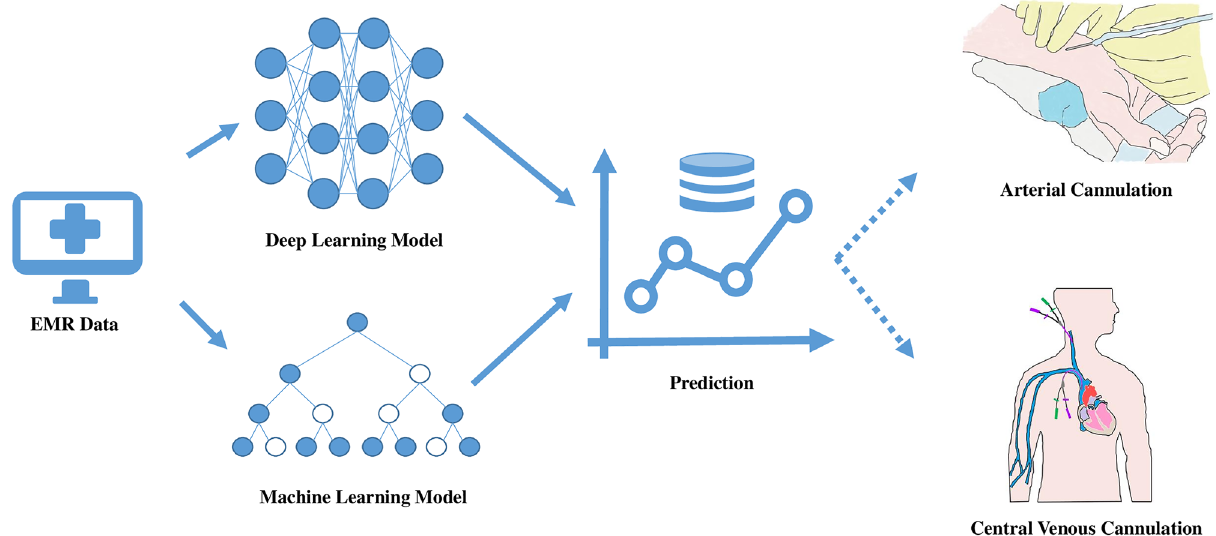
Figure 3. Schematic showing the development the predictive model for the preoperative decision of the necessity of arterial catheter or central venous catheter insertion during